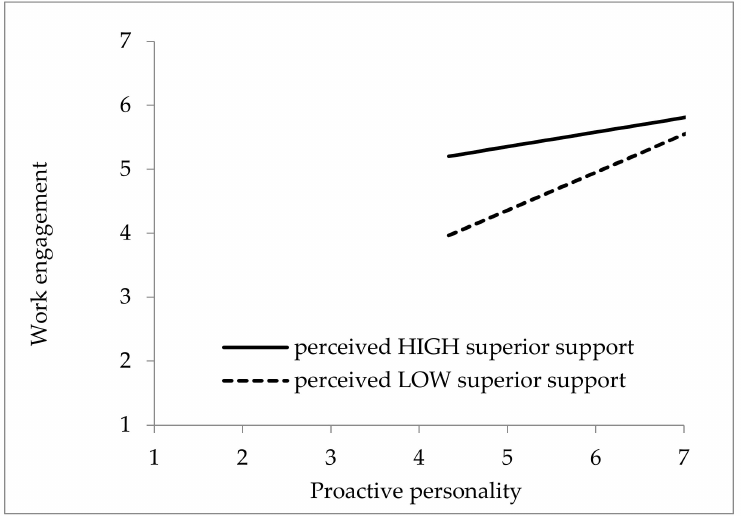
Figure 2. The interaction effect of proactive personality and perceived supervisor support on work engagement.